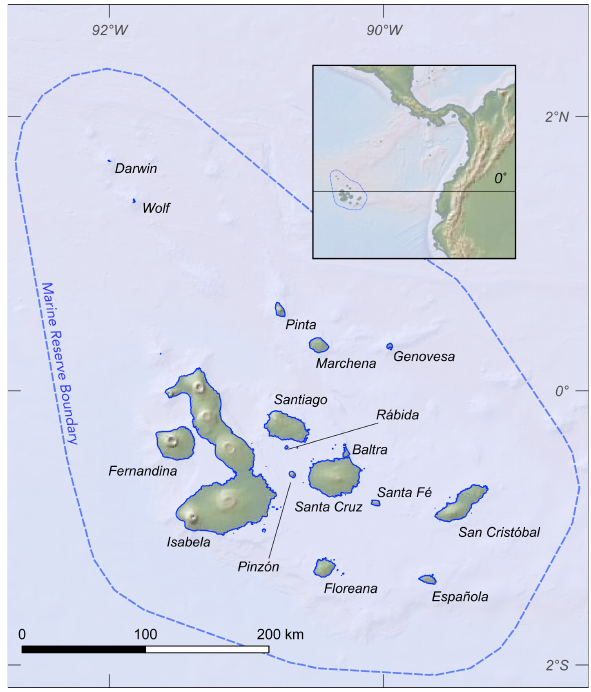
Figure 1. The Galapagos Islands and Marine Reserve are located approximately 1 000 km West from Ecuador